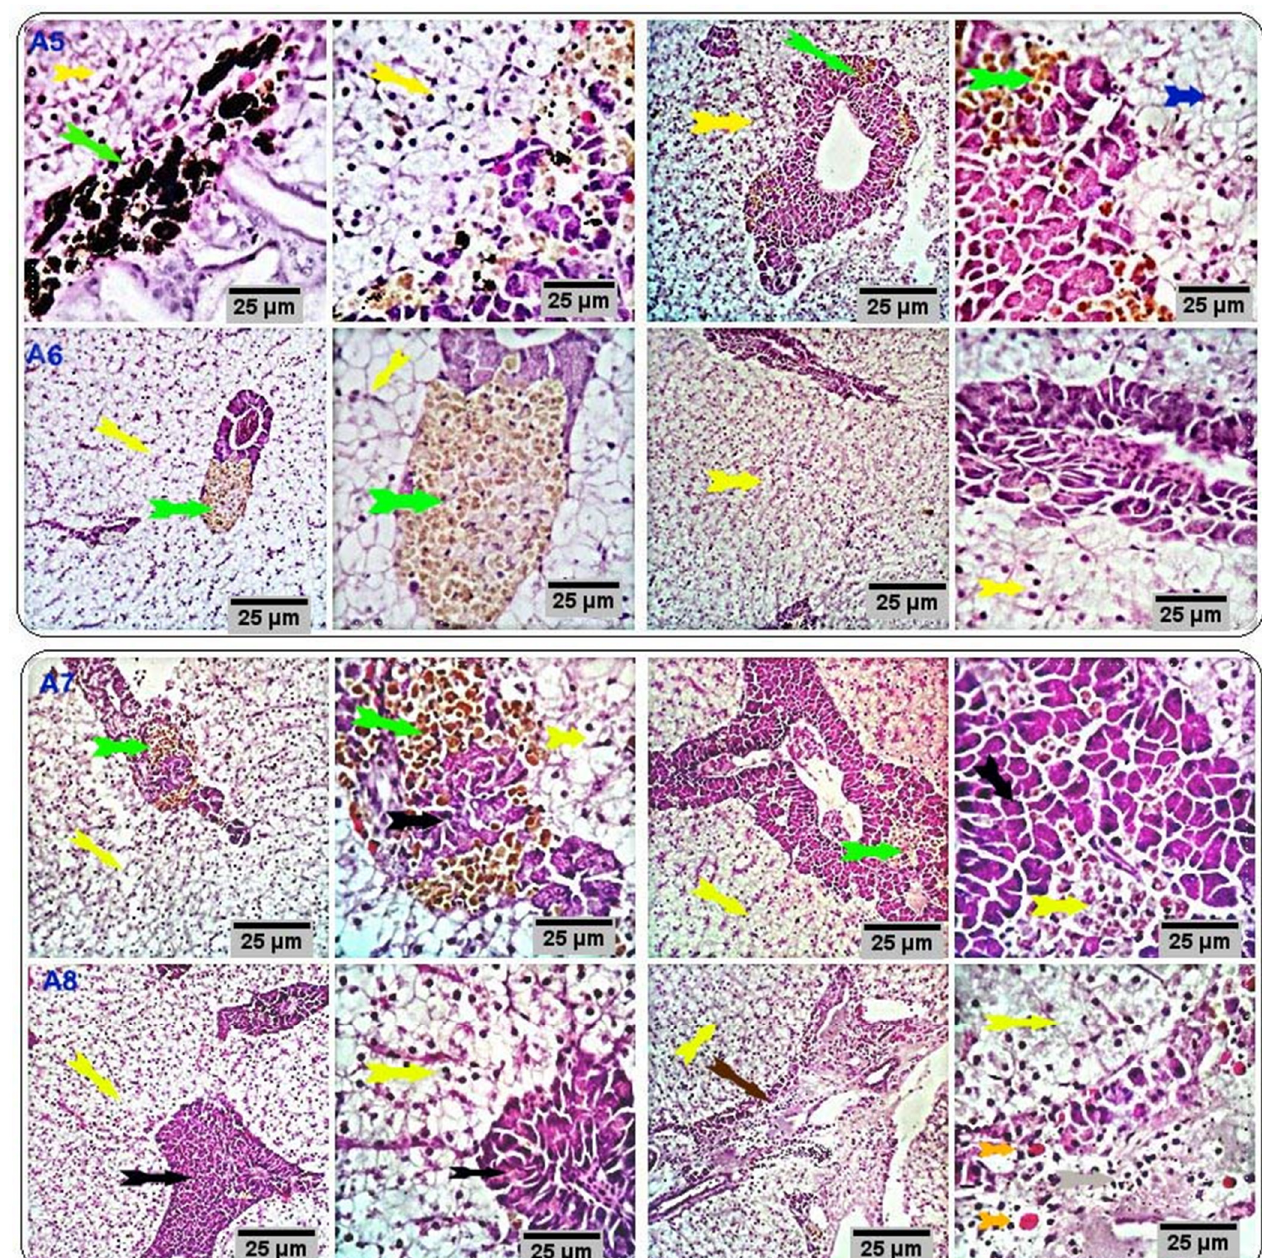
Figure 4. Stained sections of the liver of the respective treatment groups (CUR200, CUR400, CUR600, and CUR800) showing histomorphological structures comparable to that of the control group (yellow and black arrows) with activated hepatopancreatic acini and normal vascular structures with few surrounding numbers of melano-macrophages. Other sections showed marked infiltration of melano-macrophages, particularly at the hepatic portal/pancreas (green arrows) with occasional vascular dilation, edema, infiltration of eosinophilic granular cells (orange arrows), and pancreatic acinar disorganization and/or degeneration (brown arrow); some of the hepatocytes appeared degenerated (blue arrow). Scale bars = 25 µm. (A5: CUR200, A6: CUR400, A7: CUR600, and A8: CUR800).